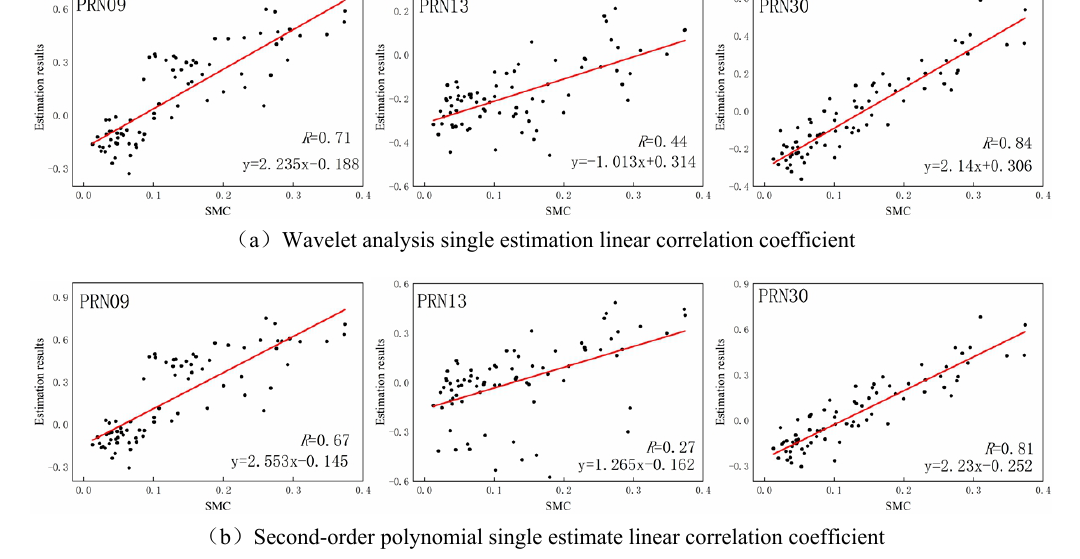
Fig.7 P041 station Schemes 1 and 3 to estimate the linear correlation coefficient Table 1 Multi-star fusion estimation R comparison